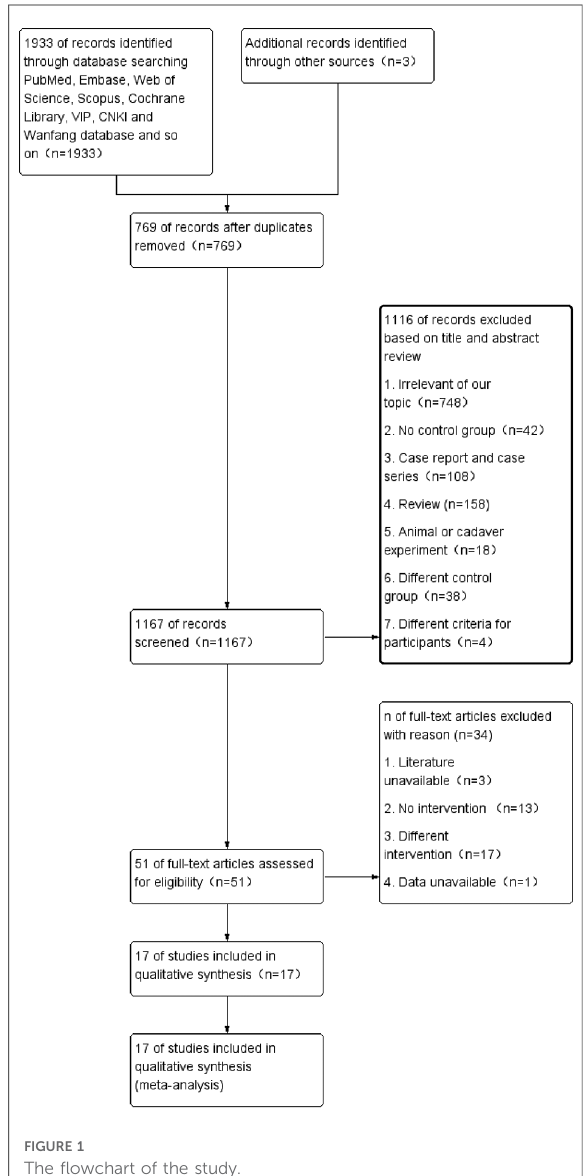
FIGURE 1 The fl owchart of the